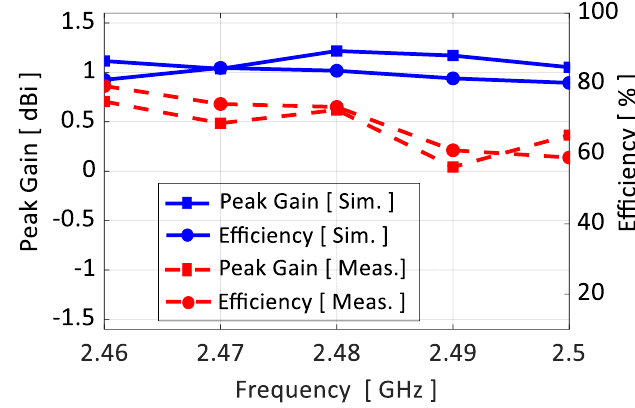
Figure 8. Simulation and measurement results of the peak gain and radiation efficiency.